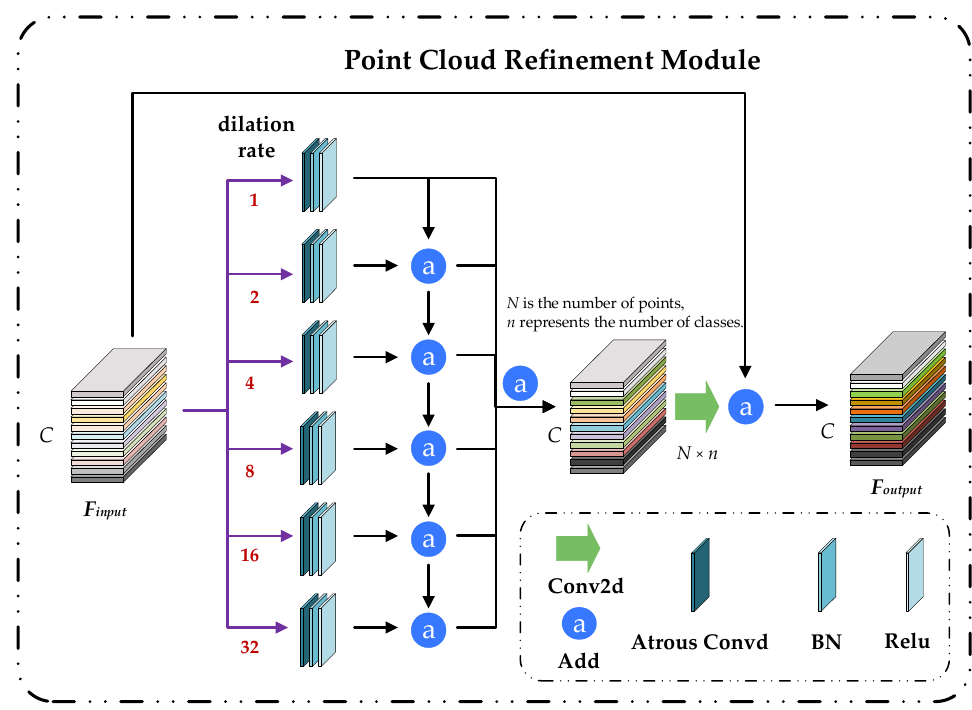
Figure 4. Point cloud refinement module (PCRM)